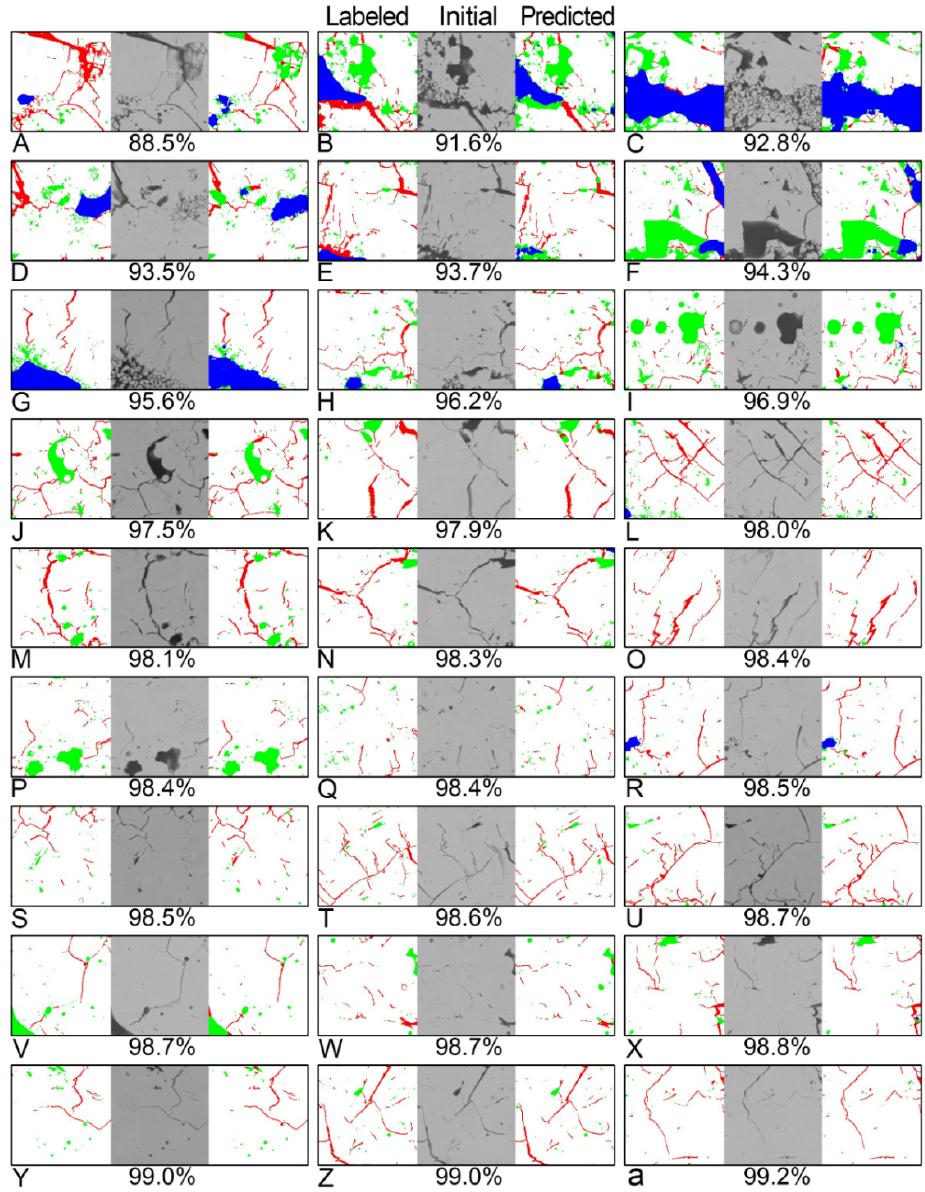
Figure 8. ( A − Z , a ) Images predicted by the model, together with the initial grayscale images, and the manually labeled images. These images were selected this way: all the predicted images were ranked according to accuracy, and then the even-numbered images were selected. The accuracy for each image is presented below each grayscale image.